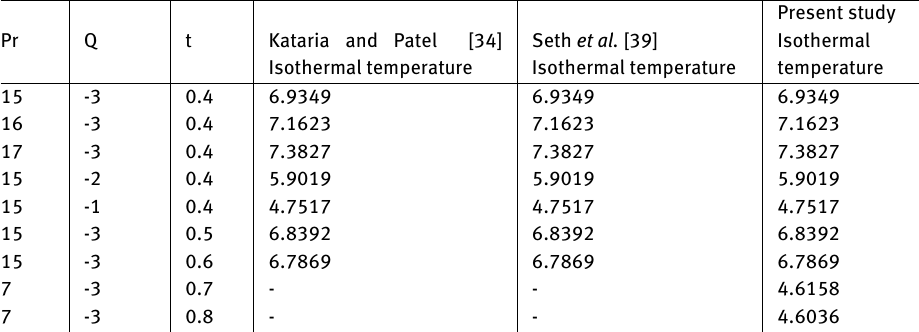
Table 1: Comparison of the current model’s Nusselt number with the findings in the literature of [34] and [39] in the absence of Radiation parameter R.